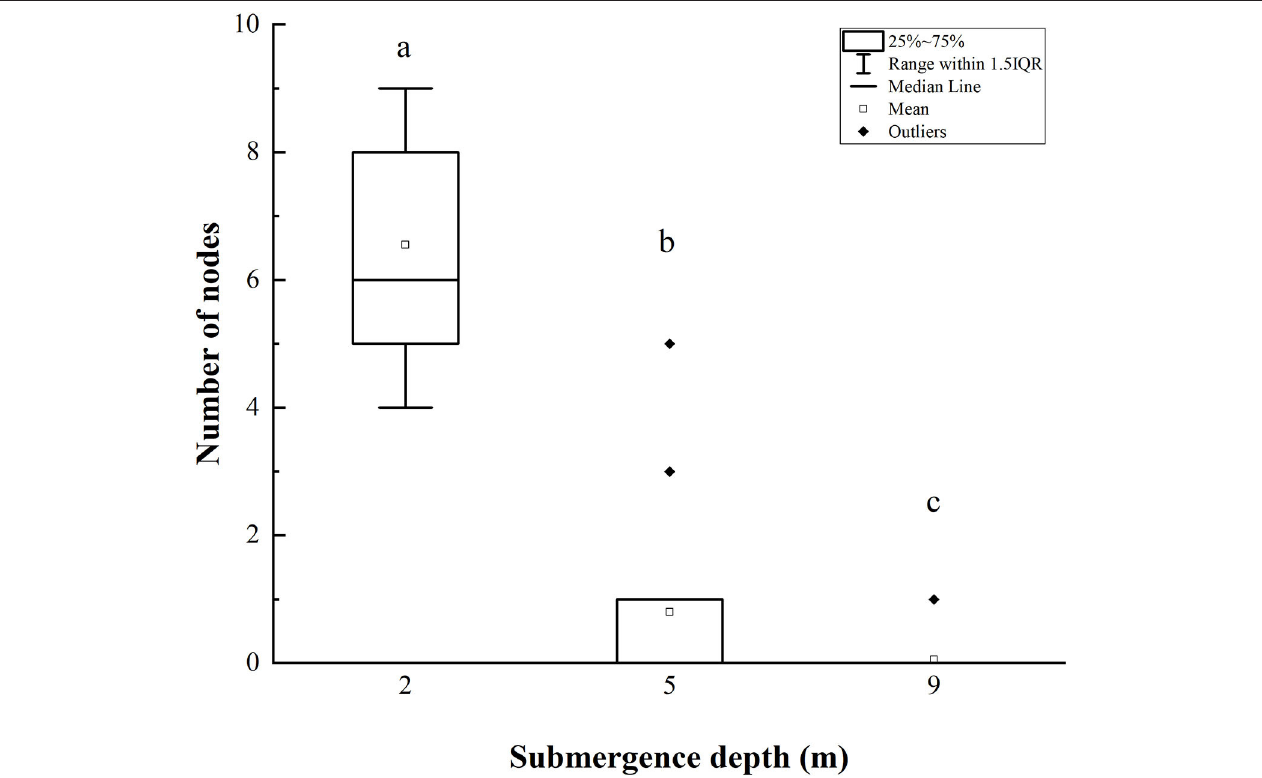
FIGURE 4 | The number of stem nodes forming adventitious roots of A. philoxeroides at the end of submergence treatments (mean ± S.E.; n = 20). Different lower-case letters indicate significant differences ( p < 0.05 using one-way ANOVA) between treatments.